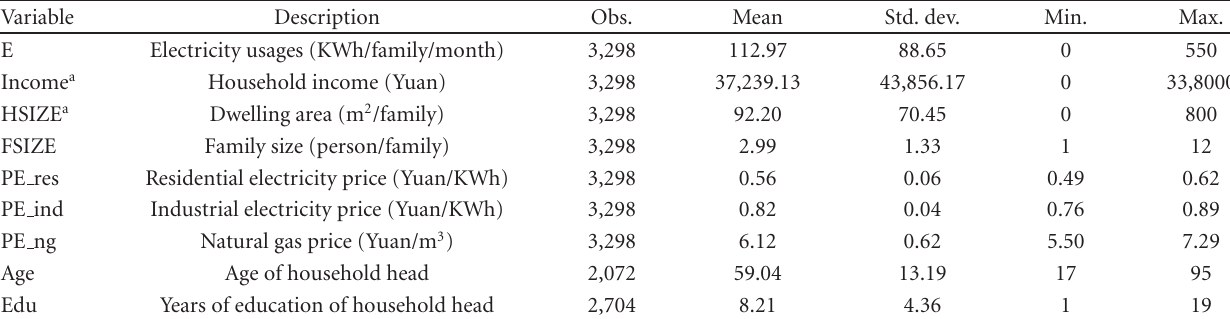
Table 1: Descriptive statistics of the household survey data.